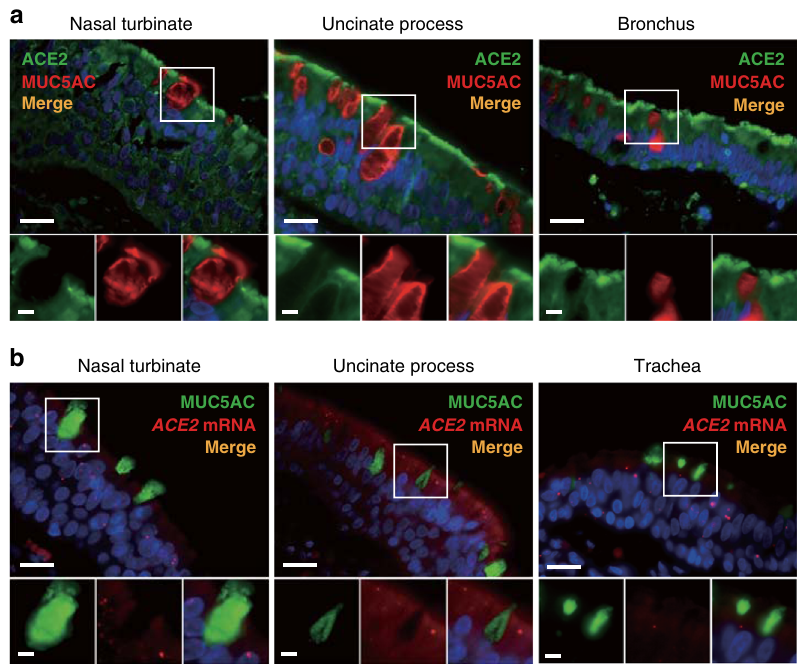
Fig. 4 ACE2 protein and mRNA expression are not found in secretory goblet cells of the human airway. a Representative immuno fl uorescence double staining of ACE2 and mucin 5AC (MUC5AC) reveals absence of co-localization of ACE2 within secretory goblet cells in the human nasal turbinate, uncinate process, and bronchus. b Representative in situ hybridization using an ACE2 probe in combination with an anti-MUC5AC antibody. ACE2 mRNA expression (red dots) was not detected within goblet cells marked by MUC5AC in the nasal turbinate, uncinate process, and trachea. Nuclei were stained using DAPI. Scale bars: 20 μ m (top) and 5 μ m